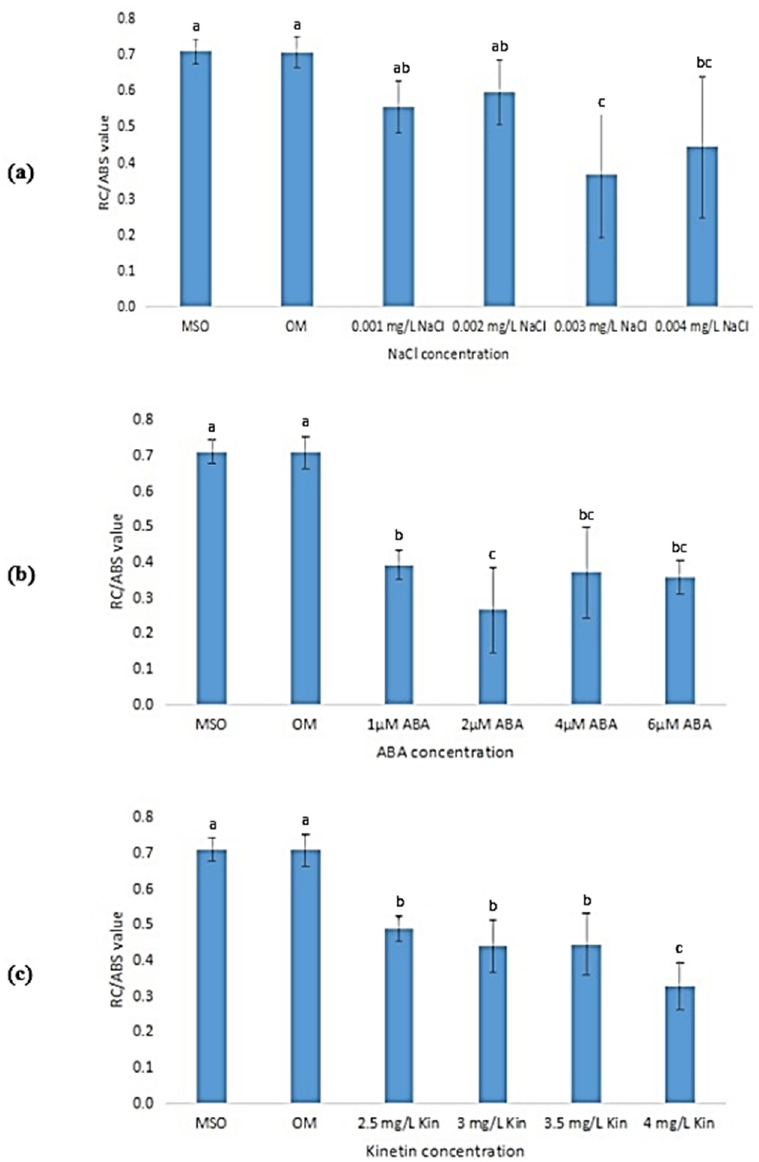
Figure 18. RC/ABS values of plants exposed to: ( a ) salt stress; ( b ) ABA; ( c ) high kinetin levels. Means with different letters are significantly different at p < 0.05 according to Duncan’s multiple range test (DMRT).